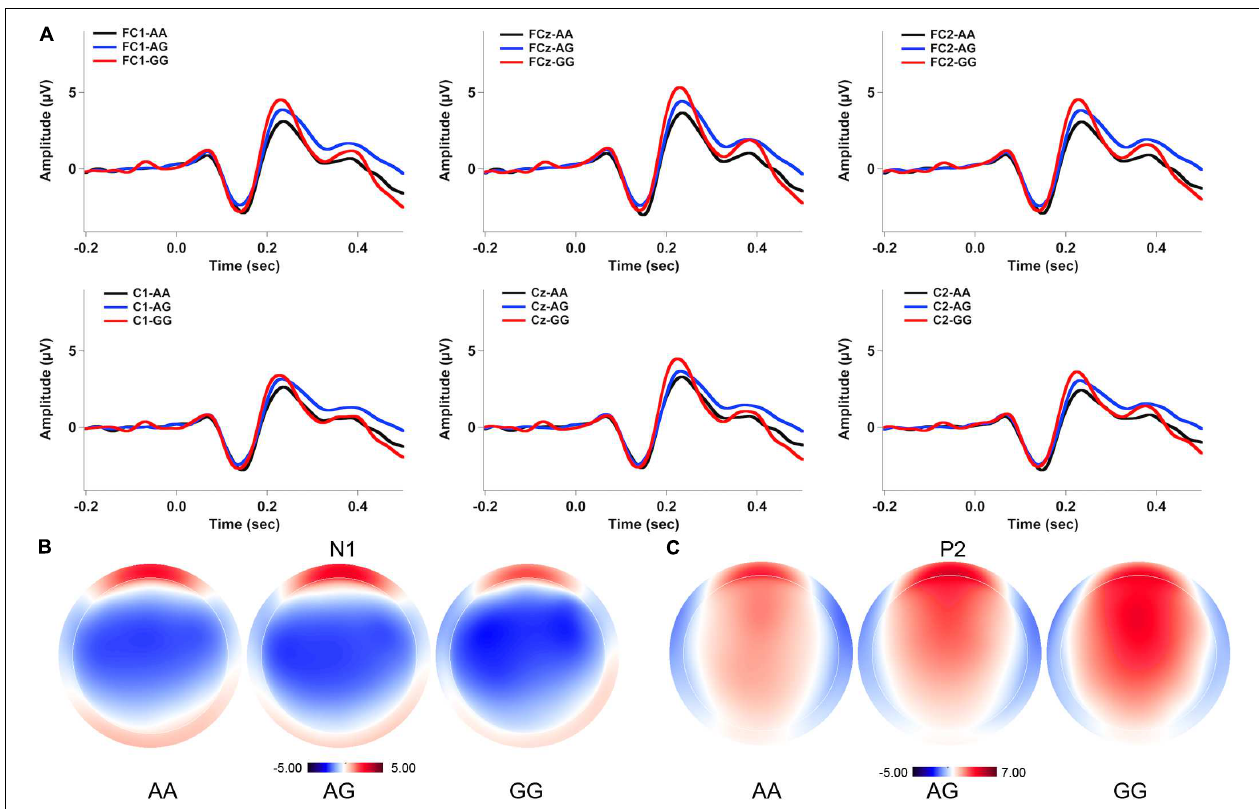
FIGURE 2 | Grand-averaged ERP waveforms (A) and topographical distributions of the N1 (B) and P2 (C) amplitudes in response to –50 cents pitch perturbations across the genotypes. The black, blue, and red solid lines represent cortical ERPs for the AA, AG, and GG genotypes,